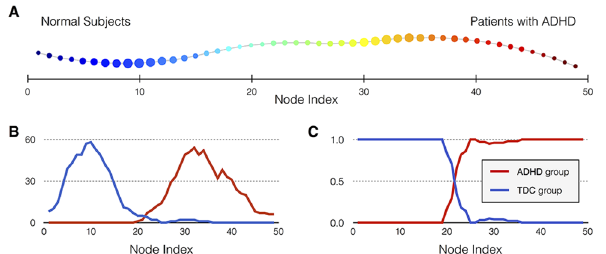
Fig 3. Resulting graph of the topological data analysis using the NYU dataset. ( A ) The ADHD-like subjects are ordered by the magnitude of deviation from the HSM. Each node is colored by the mean of the filter map on the points. Blue nodes contain normal-like subjects whose total deviations of the functional network from HSM are small (normal and normal-like subjects). Red nodes contain ADHD-like subjects whose deviations of the functional connectivity vector from HSM are large. The image of filter function was subdivided into 10 intervals with 85% overlap. ( B ) The number of subjects for each group versus node index. ( C ) The occupation ratio of group members in each node as function of node index.